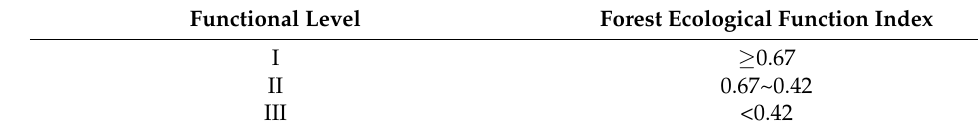
Table A2. Evaluation table of ecological function grade.